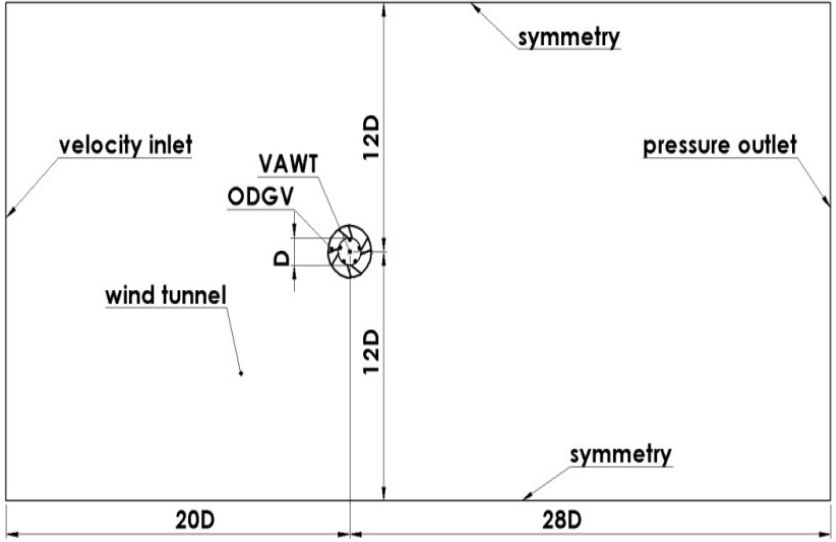
Figure 4. Wind tunnel (domain).